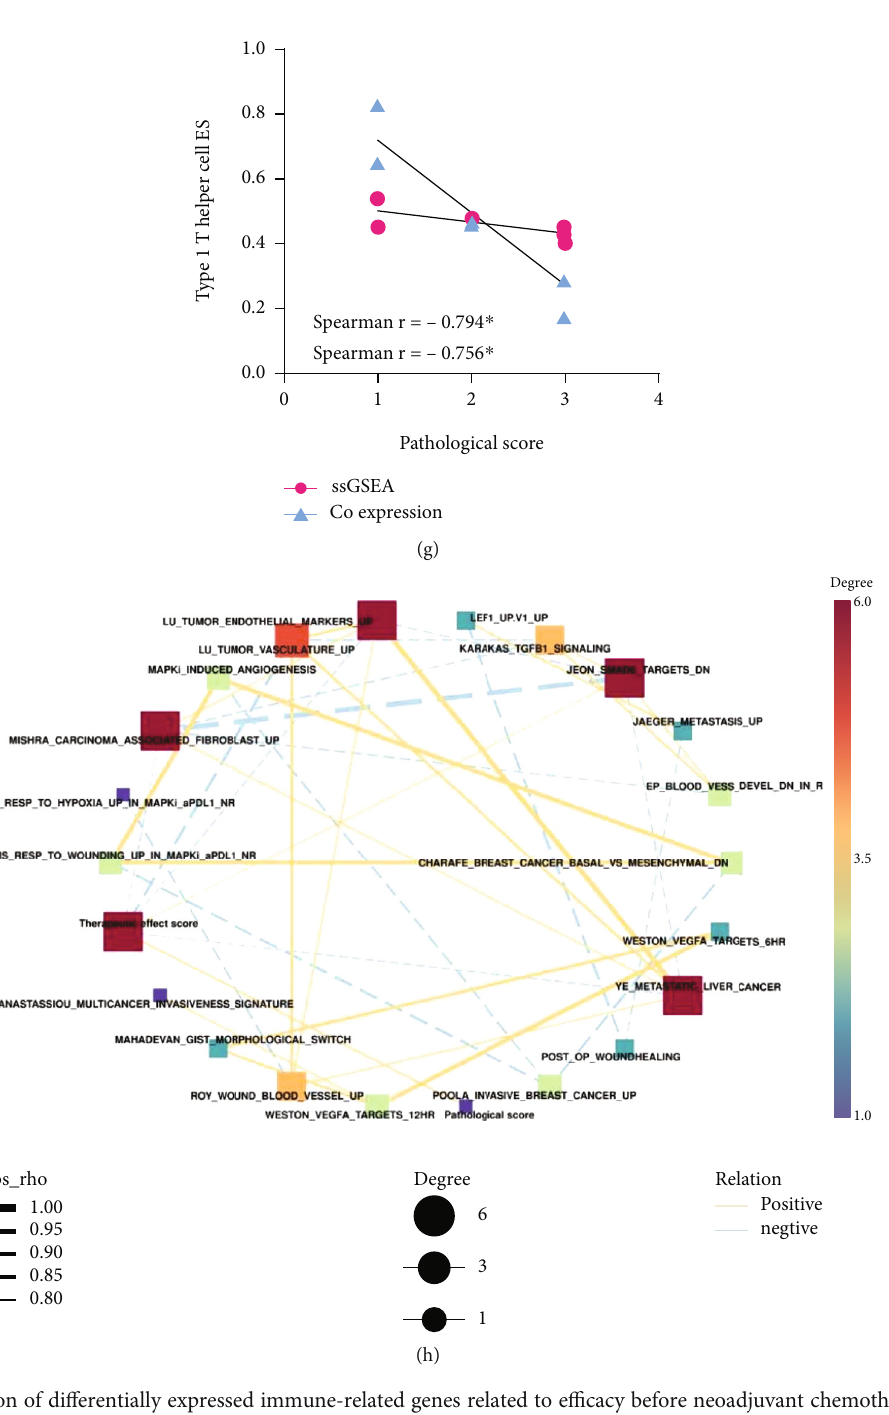
Figure 2: Identi fi cation of di ff erentially expressed immune-related genes related to e ffi cacy before neoadjuvant chemotherapy. Seven cases of bladder cancer tissues before neoadjuvant chemotherapy were divided into a favorable prognosis group ( n = 4 ) and a poor prognosis group ( n = 3 ) according to the fi nal curative e ff ect. (a) Heatmap showing the di ff erentially expressed genes. (b) Bar plot showing the di ff erentially expressed genes with signi fi cant fold change. (c) Hierarchical clustering heatmap showing the gene set variation analysis (GSVA) of gene signatures. (d) Chord diagram showing the top 5 enriched KEGG terms for 6 di ff erentially expressed genes. (e) The Spearman correlation analysis between therapeutic e ff ect score and monocyte. (f) The Spearman correlation analysis between therapeutic e ff ect score and neutrophil. (g) The Spearman correlation analysis between pathological score and Th1 cell. (h) The pathway interaction network showing the relationship with pathological score and therapeutic e ff ect score by IPRSE analysis. P values in the (a) and (b) sub fi gures were calculated by the Wilcoxon rank-sum test, while P values in the (e – h) sub fi gures were calculated by Spearman correlation analysis. Di ff erences were found to be statistically signi fi cant at ∗ P < 0 : 05